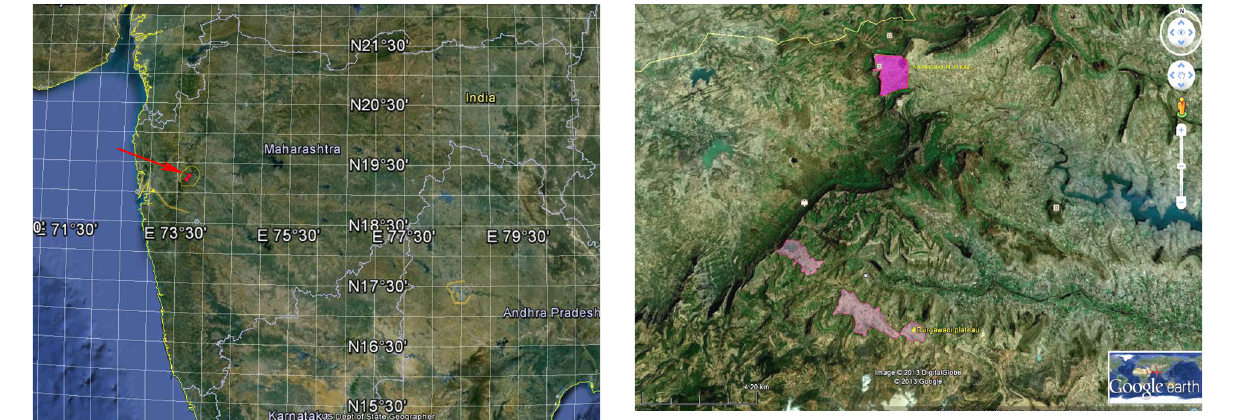
Image 2. The terrain map revealing topography of the Durgawadi and Naneghat plateaus under